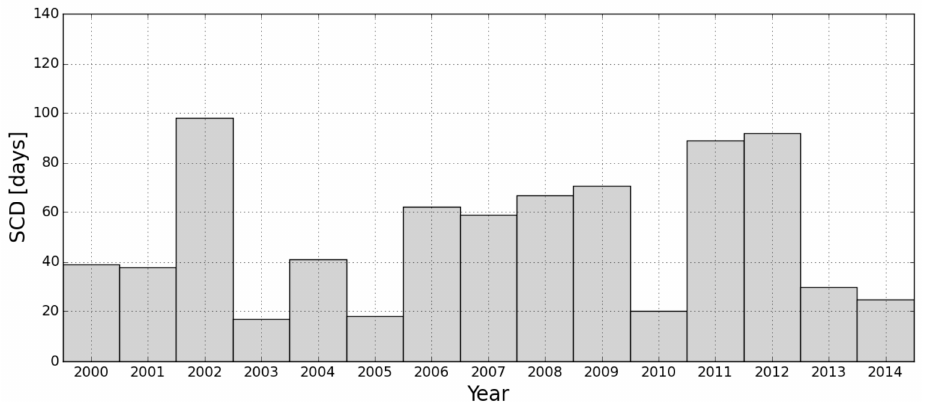
Figure 9. Annual snow cover duration (accumulated days); a day is counted as a snow cover day whenever the country of Lesotho is covered with snow by more than 0.5% of the area.